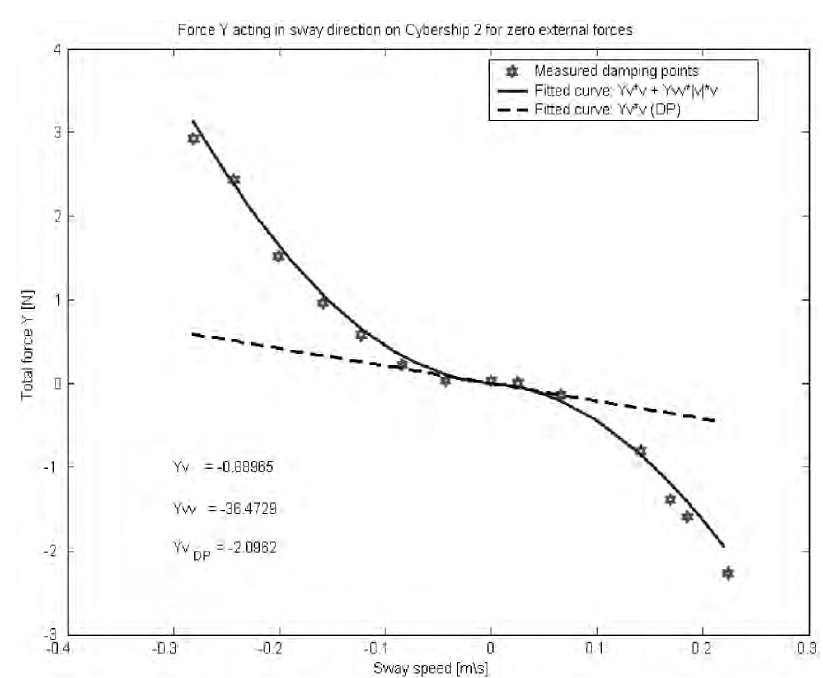
Figure 8. Measured drag forces in sway motion and the corresponding fitted nonlinear curve as well as a linear curve for DP for CyberShip